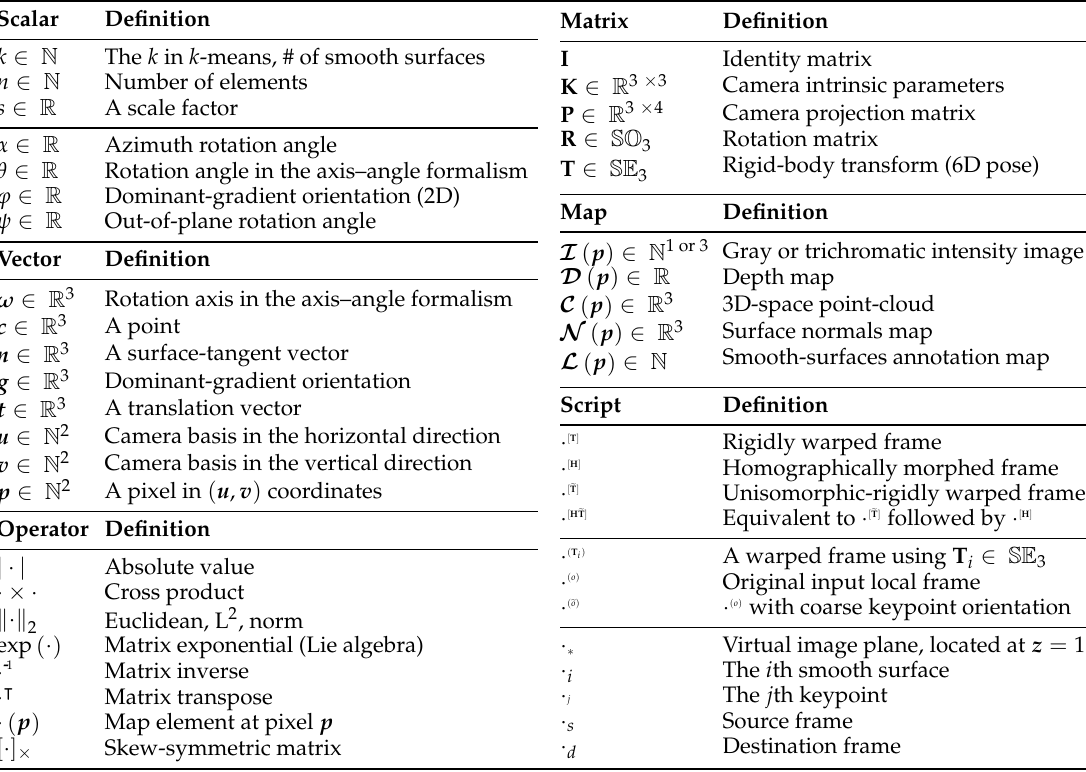
Table 1. Table of notations used throughout the manuscript, where N is the natural numbers set, R is the real numbers set, SO is the special orthogonal group, and SE is the special Euclidean